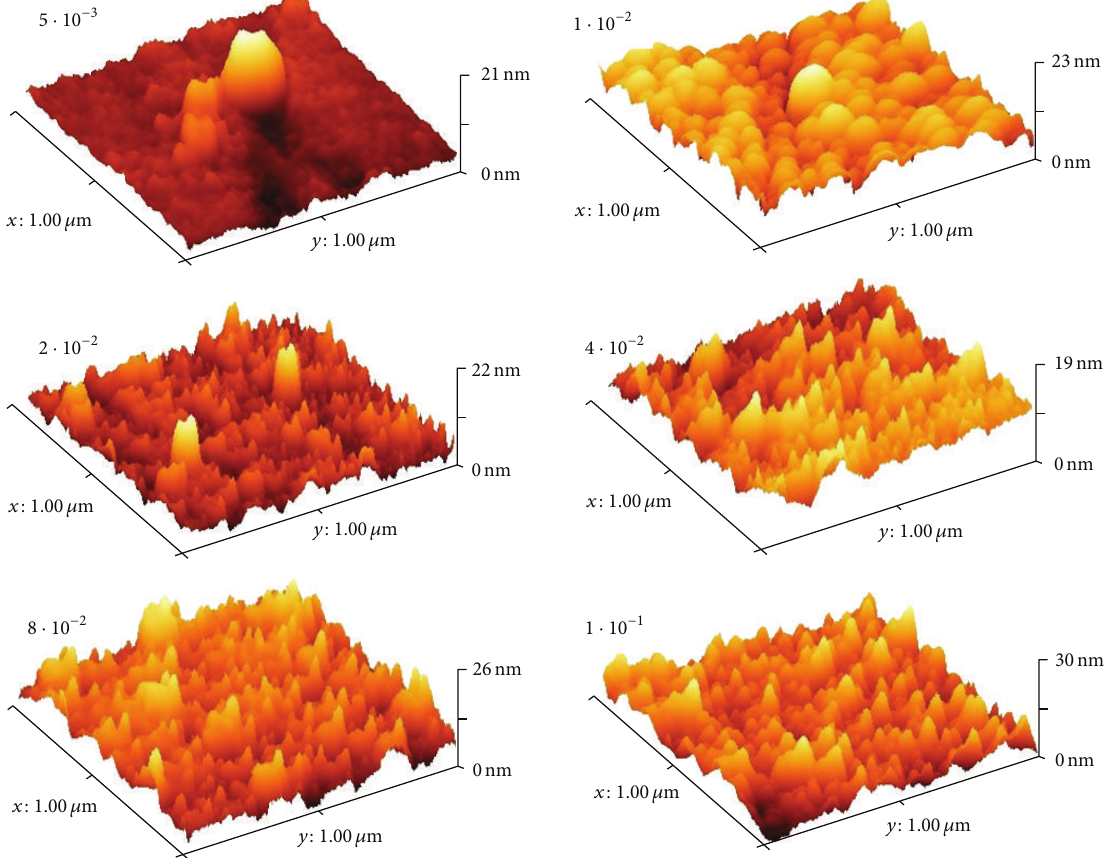
Figure 3: AFM images of Pd films deposited at various sputtering pressures.